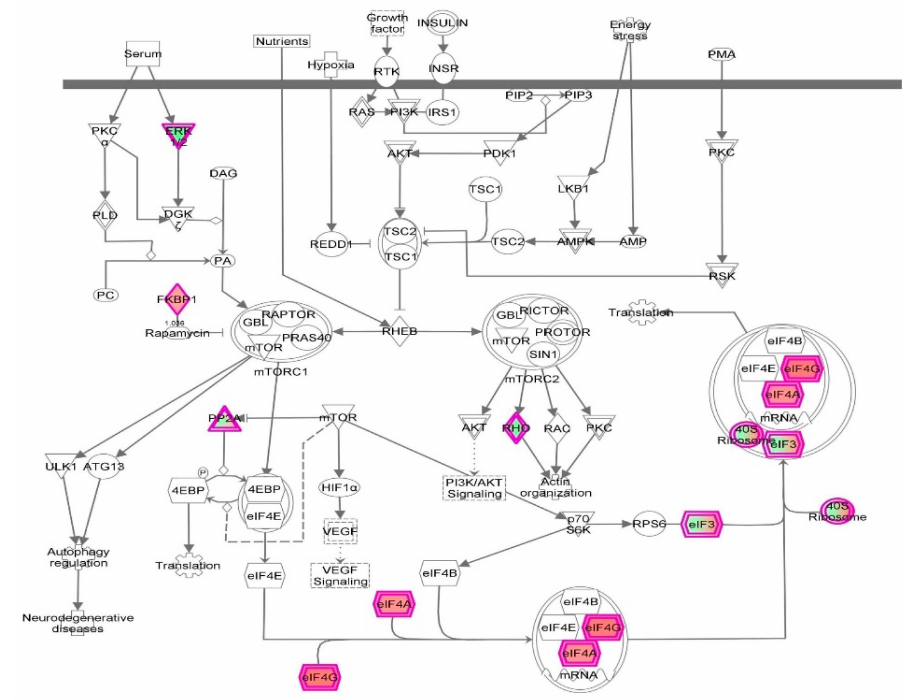
Figure 30. mTOR signaling pathway was regulated by vancomycin in HK-2 cells. HK-2 cells were treated with 50 µ g/mL vancomycin for 24 h and the protein samples were subject to quantitative proteomic analysis. Red indicates an up-regulation; green indicates a down-regulation. The intensity of green and red colors indicates the degree of down- or up-regulation. Solid arrow indicates direct interaction and dashed arrow indicates indirect interaction.